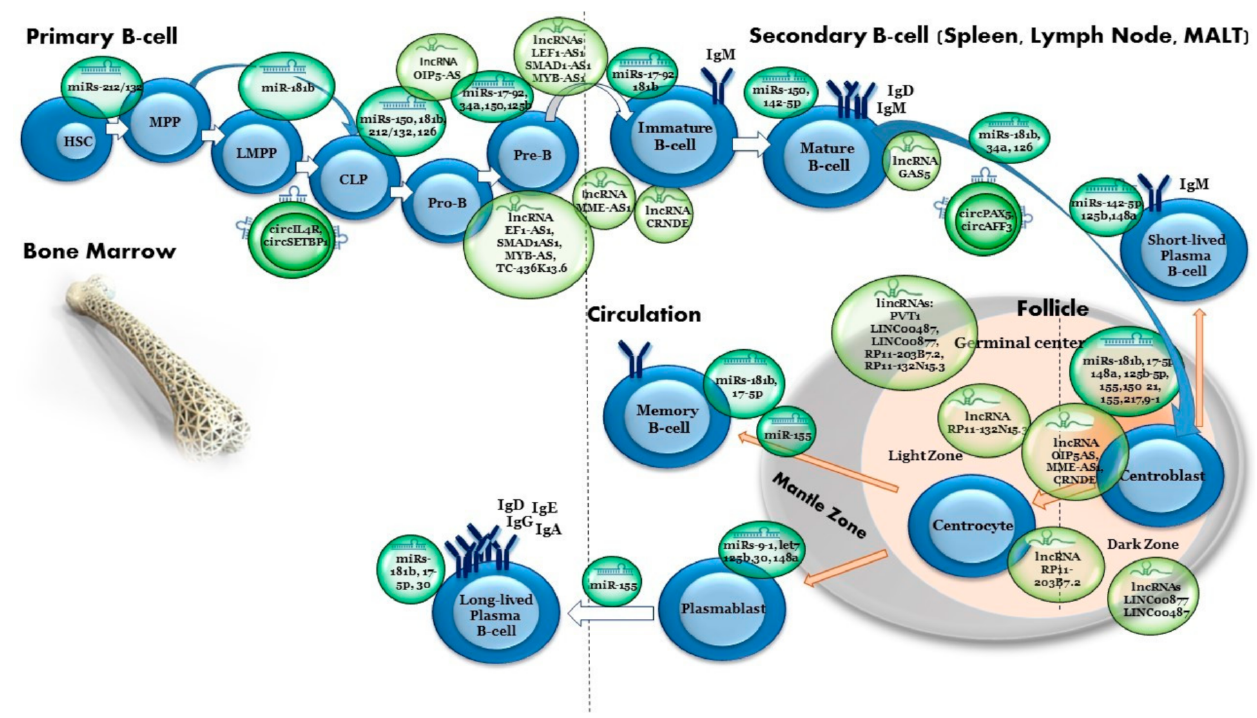
Figure 1. The role of ncRNAs in B-cell development. Normal B-cell development. B-cell development is a stepwise process initiated from hematopoietic stem cells (HSCs) in the bone marrow that develops with multipotent progenitors (MPPs) and further to lymphoid multipotent progenitors (LMPPs) and common lymphoid progenitors (CLPs). At the pro-B- and pre-B-cell stages, the genes encoding the immunoglobulin heavy and light chains of a B-cell receptor (BCR) undergo V(D)J recombination. From the mature B-cell stage onwards, each B cell expresses a unique and functional BCR. Further maturation of B cells occurs in the spleen and gives rise to follicular B cells or a marginal zone. Upon stimulation by cognate antigen, B cells enter the germinal center (GC) where they proliferate and become plasma B cells or memory B cells. Regulation by ncRNAs molecules is listed throughout the differentiating